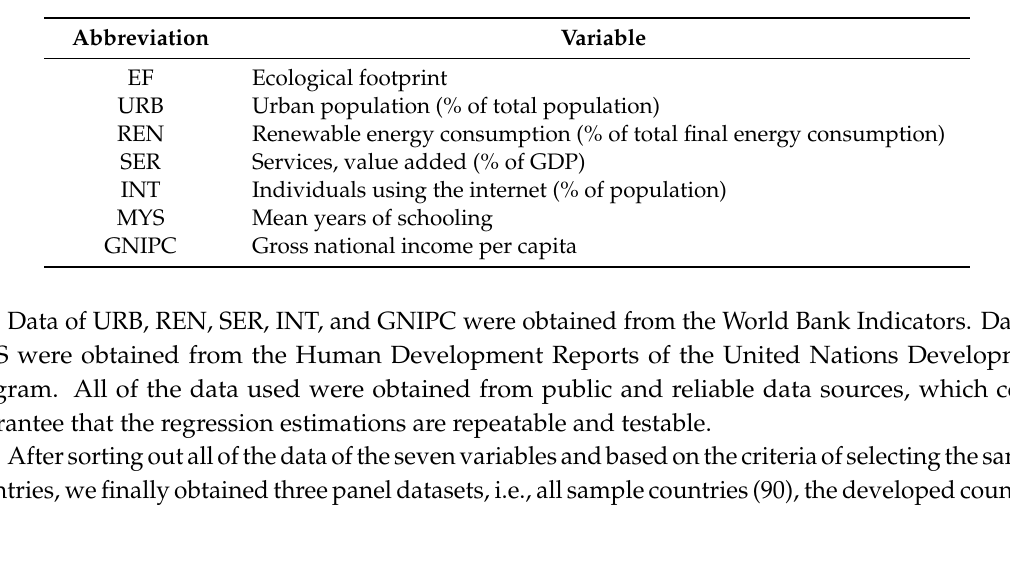
Table 2. List of abbreviations of the regression